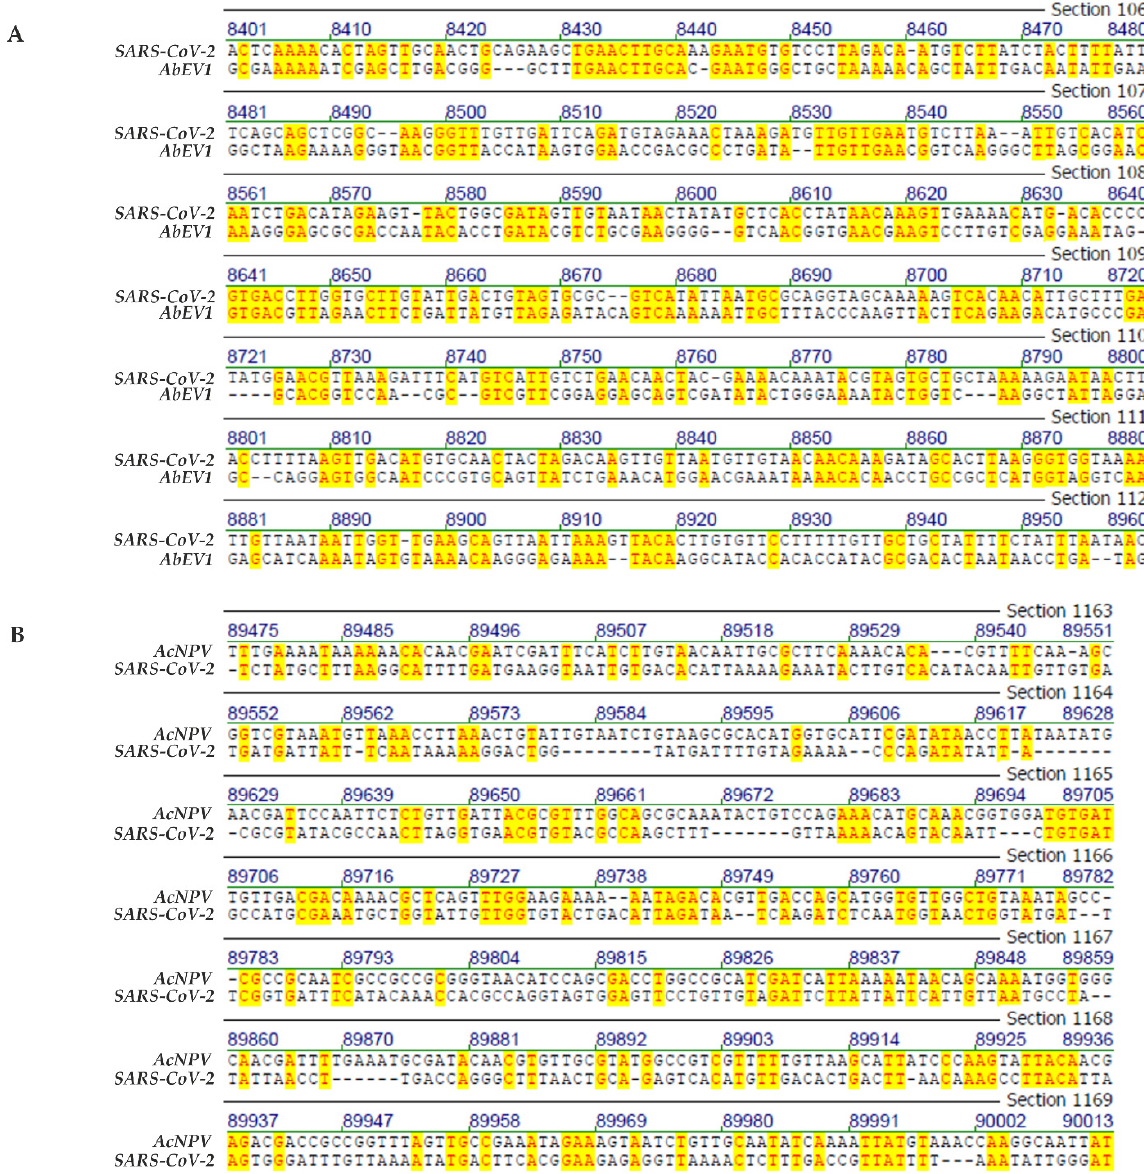
Figure 3. ( A ) Sequence alignment between the genomes of Wuhan SARS-CoV-2 and of Alternaria brassicicola endornavirus (AbEV1) . ( B ) Sequence alignment between the genomes of Wuhan SARS-CoV-2 and of Autographa californica nuclear Polyhedrosis Virus (AcNPV) . The yellow highlight designates sequence identities between the genome of Alternaria brassicola endornavirus ( AbEV1 ) ( A ), or Autographa californica Nuclear Polyhedrosis Virus (AcNPV) (B) with the genome of SARS-CoV-2. 2. Homologies between SARS-CoV-2 RNA and proteobacterial and bacterial genomes (i) Genome comparison: SARS-CoV-2 and Candidatus Carsonella ruddii strain BT Psyllids are primitive plant-specific and plant-feeding insects that harbor obligate endosymbionts like Candidatus Carsonella ruddii, a proteobacterium with one of the small-